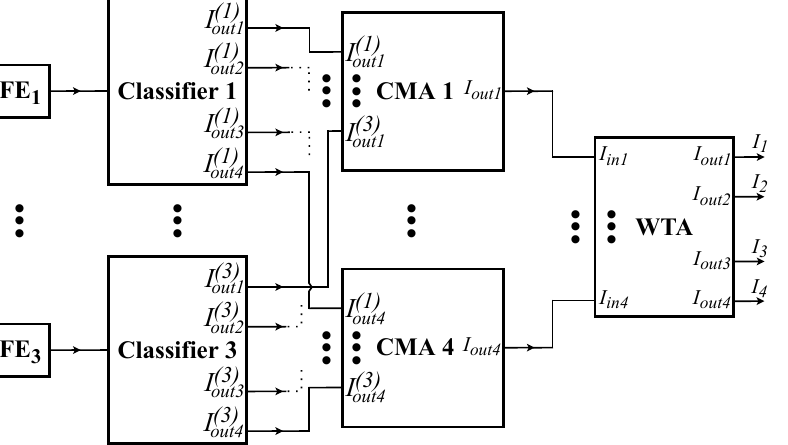
Figure 8. The system-level implementation of the proposed voting classifier is composed of 3 processing parts: ( left ) analog feature extraction (FE) ( middle ), analog classifiers ( right ), and analog voting circuit.